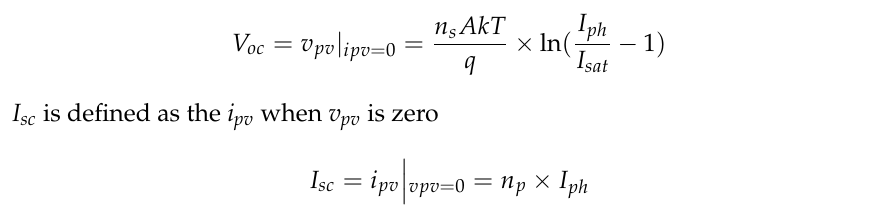
Figure 3. The equivalent circuit for a PV cell.